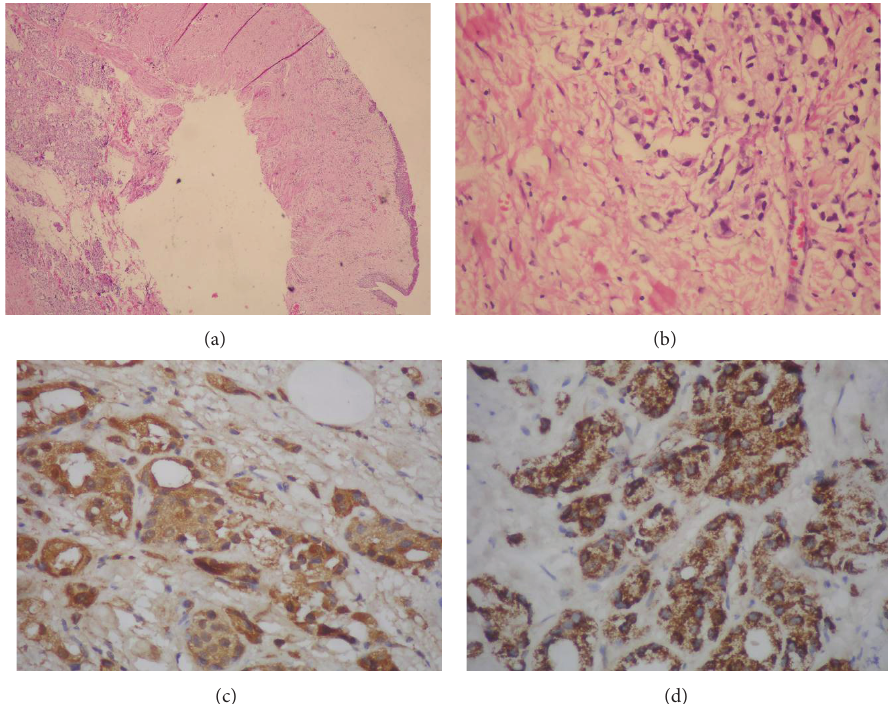
Figure 2: Histopathology of the right ureter represented a skipped lesion of a metastatic prostate adenocarcinoma. ((a), (b)) Histopathology of the right ureter revealed metastatic prostate adenocarcinoma. (a) Histopathology of the ureter representing adenocarcinoma of the prostate (hematoxylin and eosin × 40), (b) with higher magnification (hematoxylin and eosin × 400). ((c), (d)) Excisional biopsy of the right ureteral mass staining for prostate specific antigen (PSA) and P504s in slides (c) and (d),